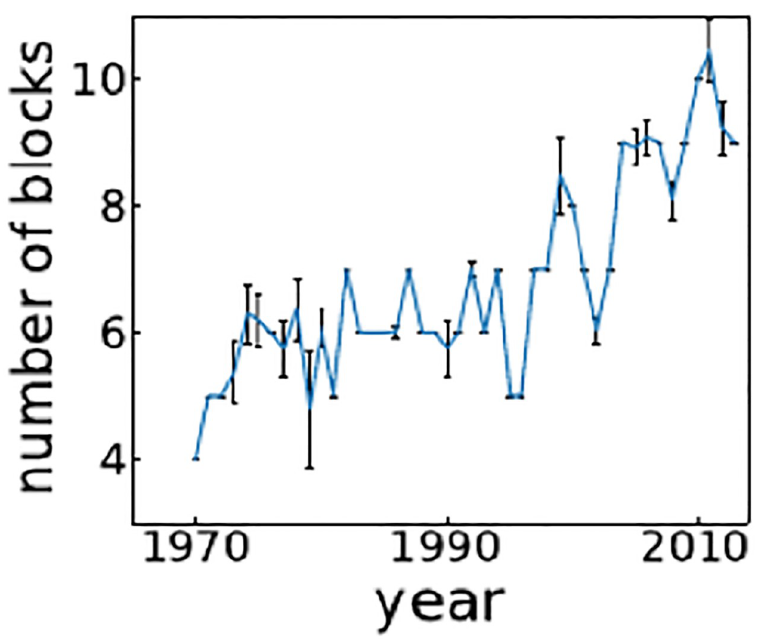
Fig 4. The number of blocks. Averaged over 100 samples in posterior probability distribution sampling. Error bars show the standard deviation.